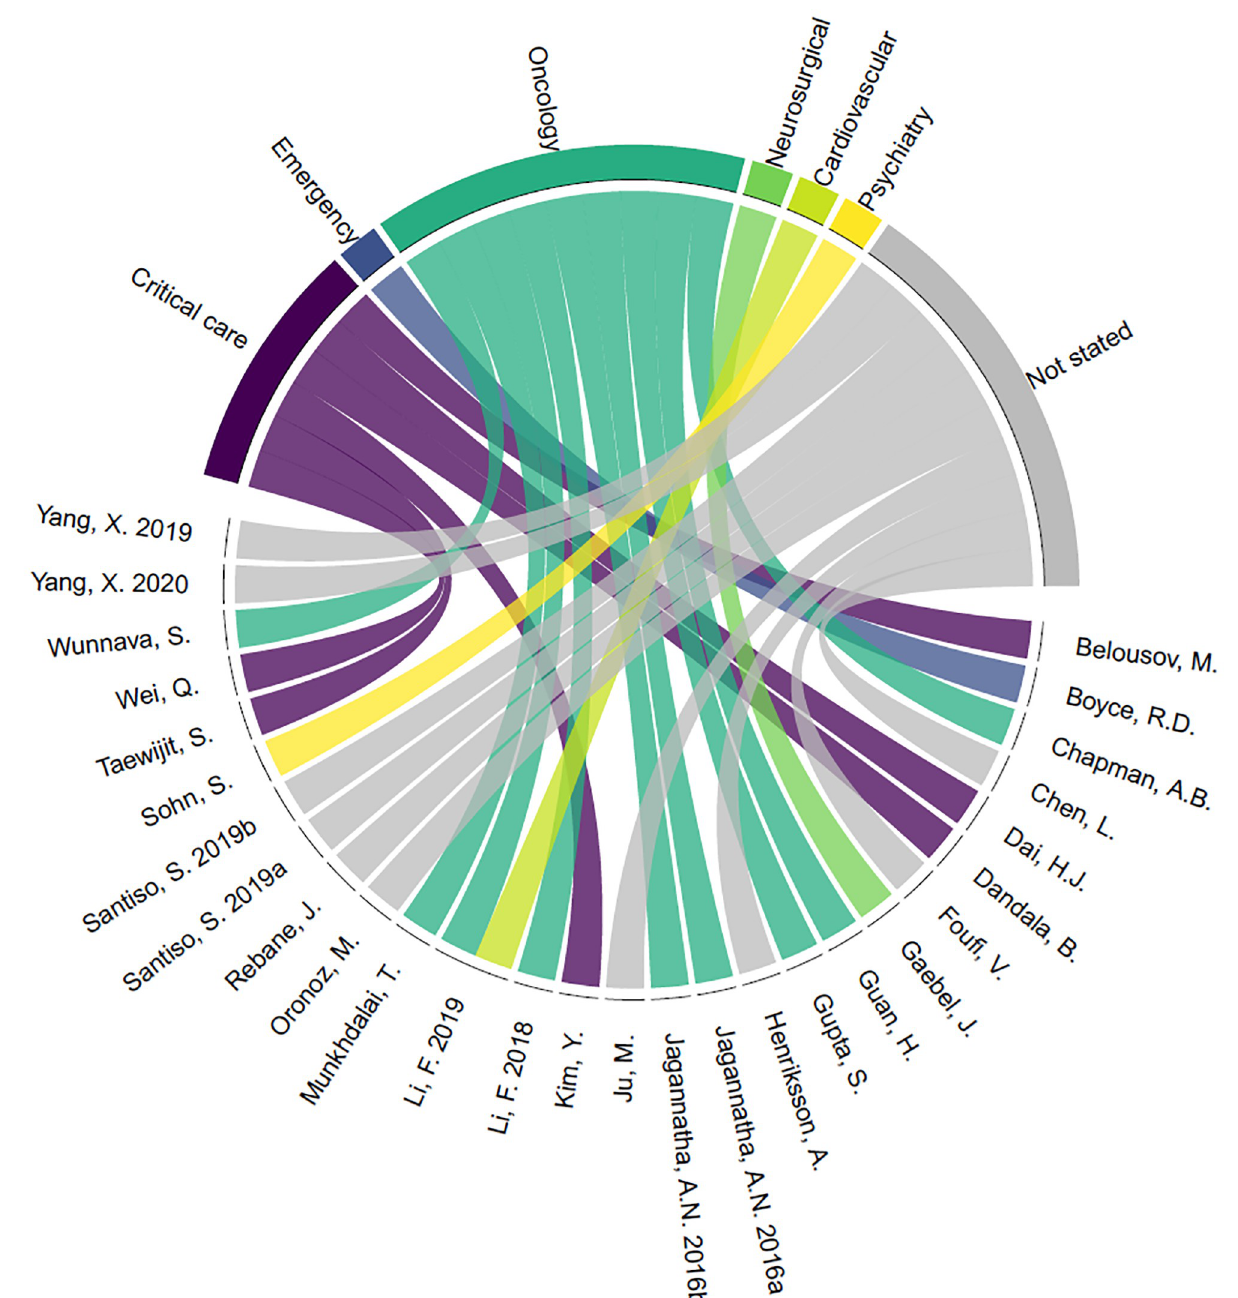
Fig 4. Patient type studied in each article (chord diagram from circlize